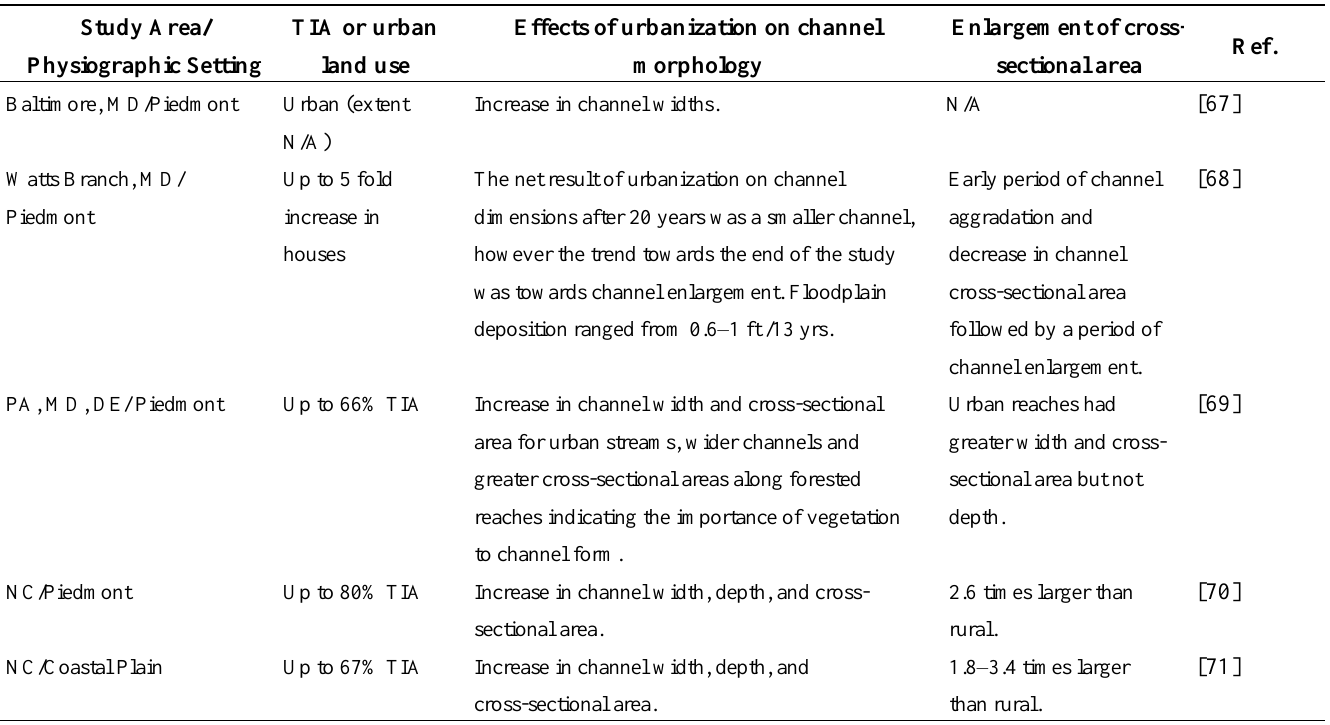
Table 2. Stream channel geomorphological responses to urbanization documented in the southern